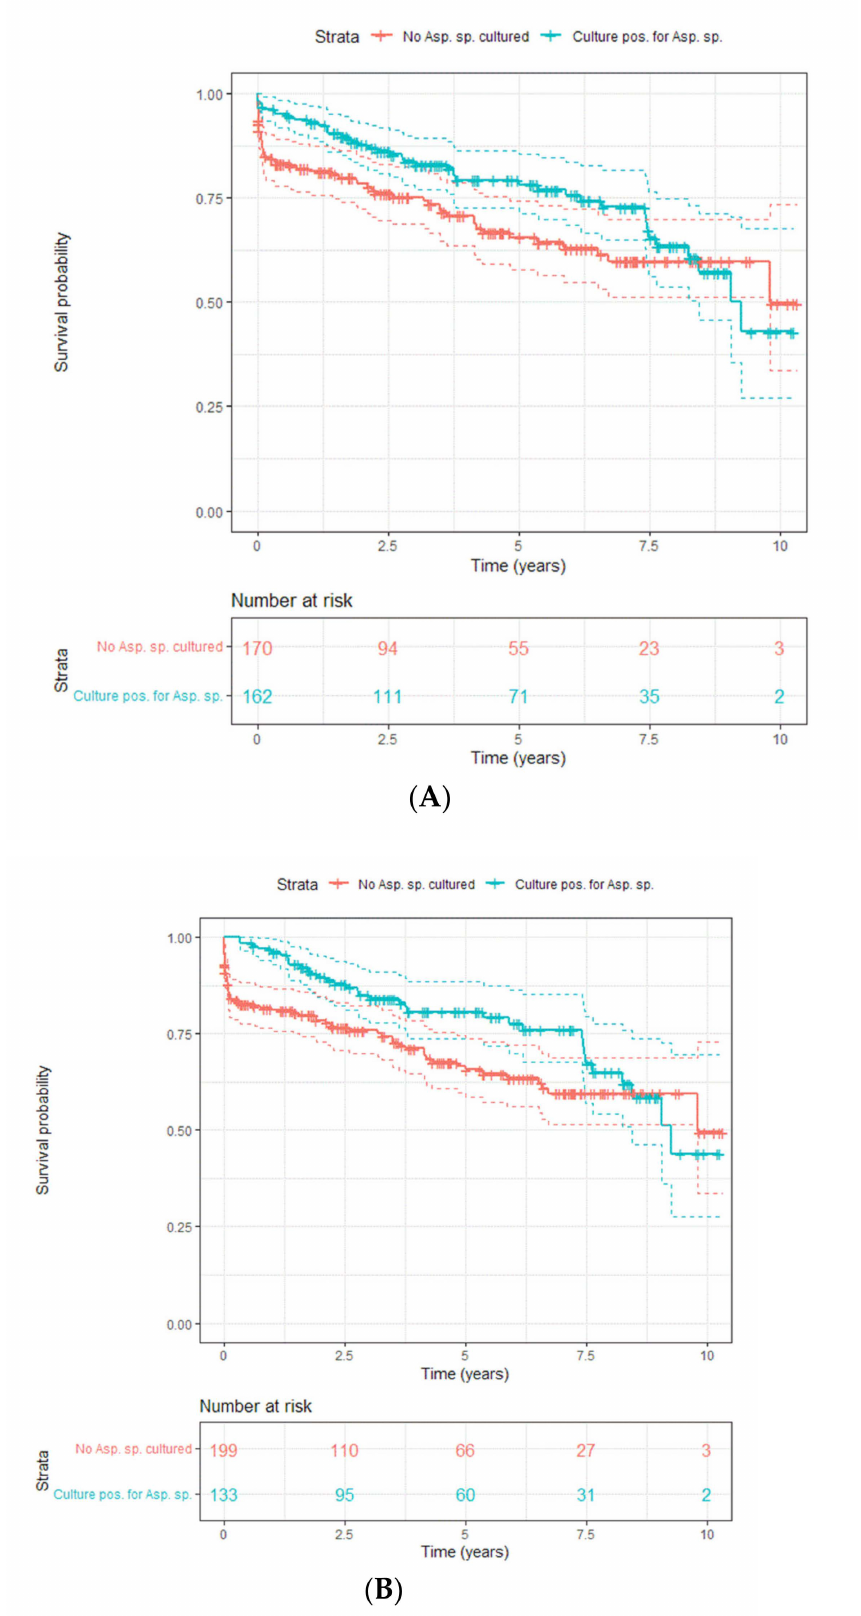
Figure 1. ( A ). Kaplan-Meier curve of patients who received a first lung transplant within the study window, stratified for any culture positive for Aspergillus vs. no positive cultures (with 95% CI). ( B ). Kaplan-Meier curve of patients who received a first